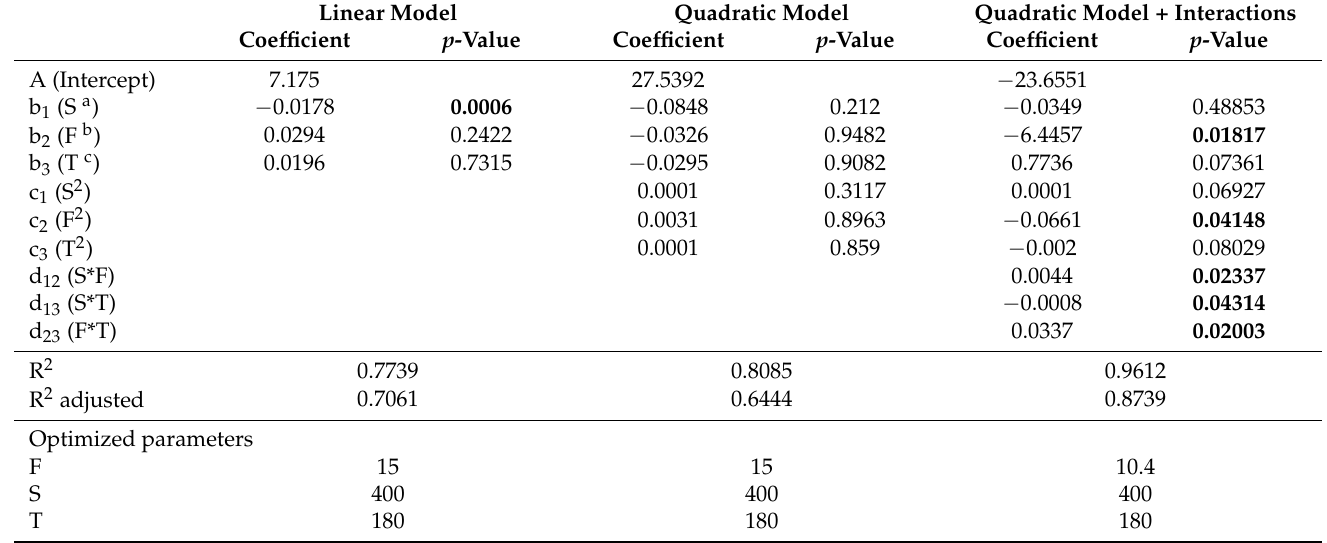
Table 1. Estimated model coefficients, p -values, and optimized parameters regarding maximal biomass yield. Significant p -values ( σ = 0.05) are highlighted in